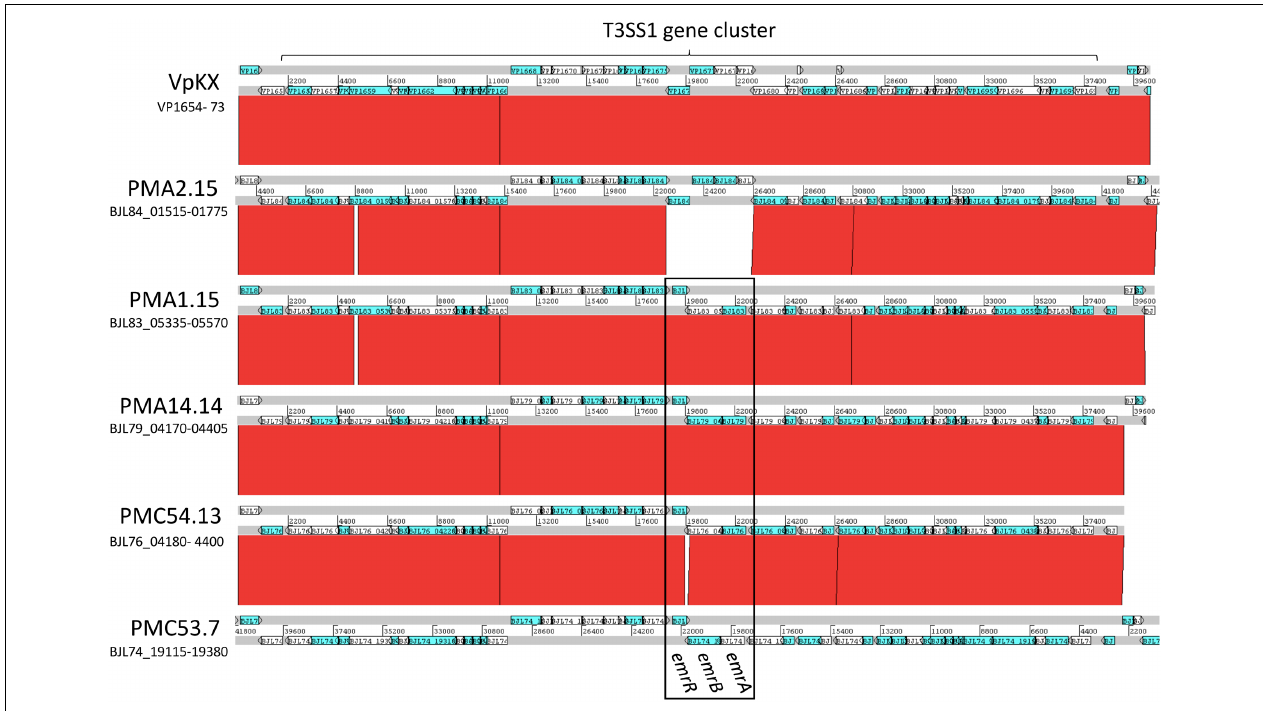
FIGURE 2 | Comparative analysis of the genomic context of the T3SS1 gene cluster in V. parahaemolyticus strains. DNA-based comparison of the T3SS1 gene cluster of strains VpKX, PMA2.15, PMA1.15, PMA14.14, PMC54.13, and PMC53.7. The region encoding the putative EmrAB efflux pump and EmrR regulator is highlighted in a box. BlastN analysis was performed using WebACT and displayed with the ACT software.